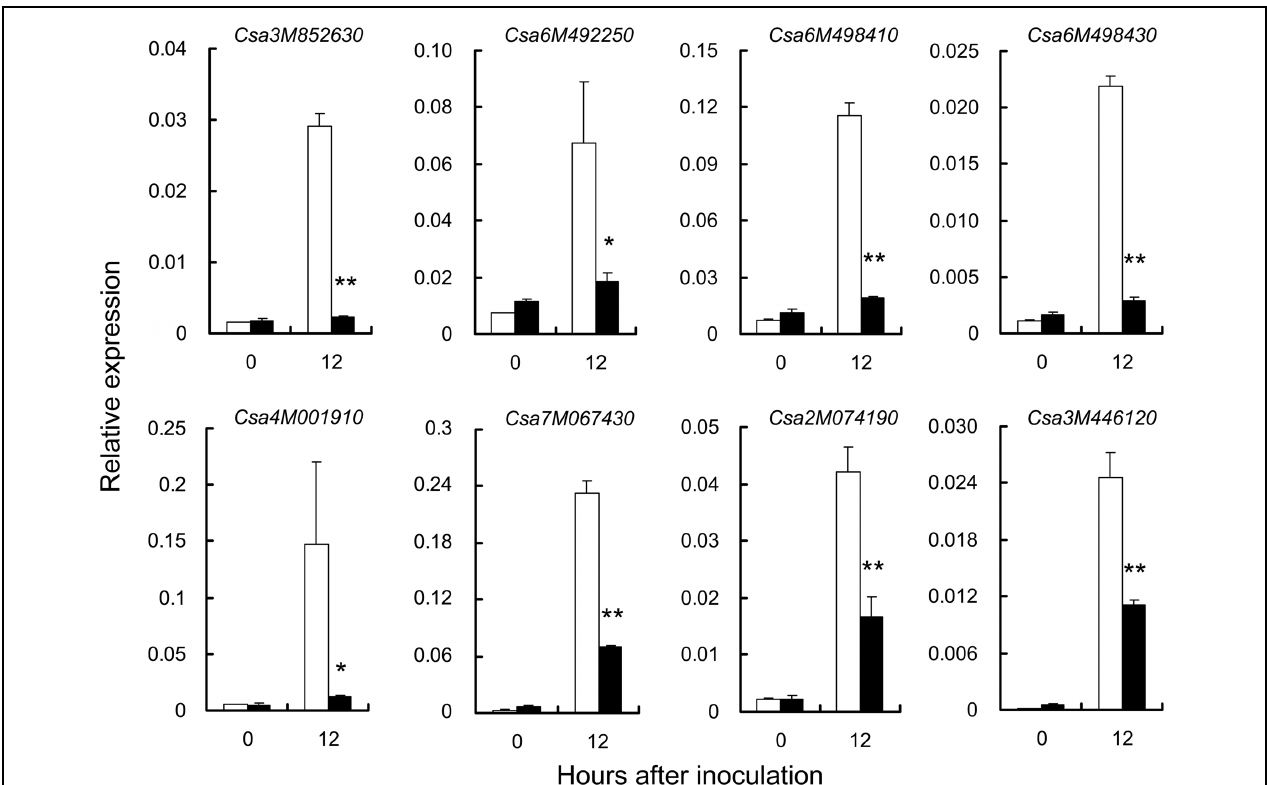
FIGURE 8 | Verification of differentially expressed genes (DEGs) by qRT-PCR. DEGs were randomly chosen from the RSG and CEG sets in Figure 7 . The cucumber CsActin gene was used to quantify the relative transcript levels. Open bars, resistant S1003; solid bars, susceptible NIL( Pm5.1 ). Values are mean ± SE ( n = 3) ( ∗ and ∗∗ indicate significant differences between S1003 and NIL( Pm5.1 ) at P = 0.01 and 0.05,